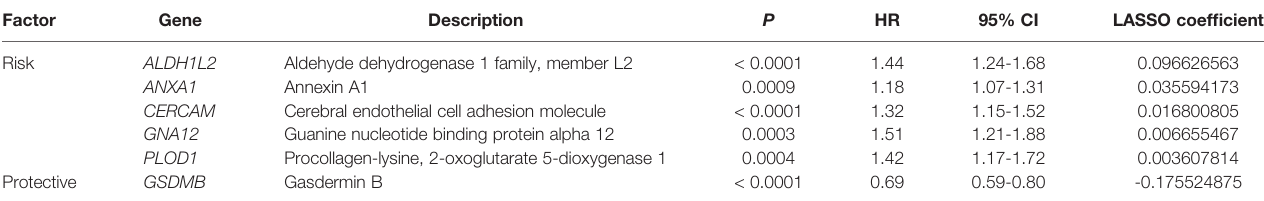
TABLE 2 | Risk signature based on PVR -related genes in training set.